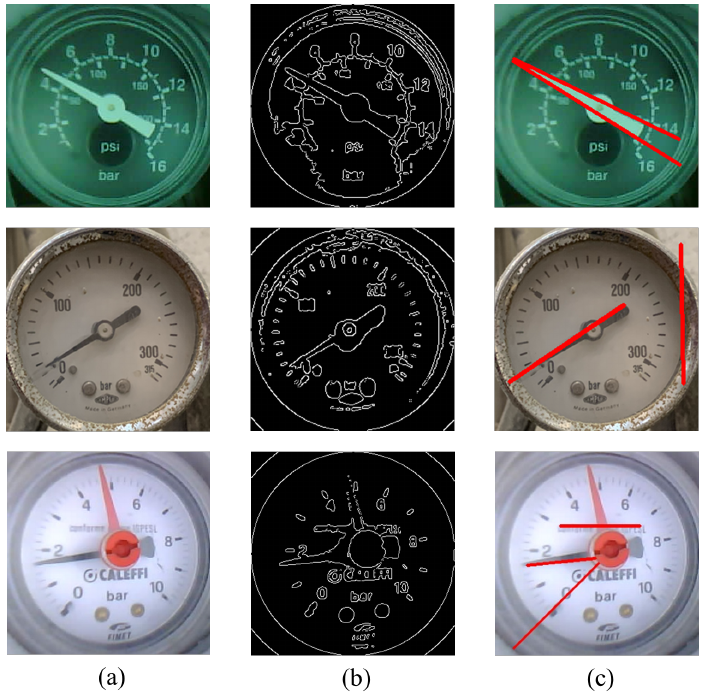
Figure 11. Application of the Hough line transform. ( a ) Original image, ( b ) Canny edge detection, ( c ) Hough line